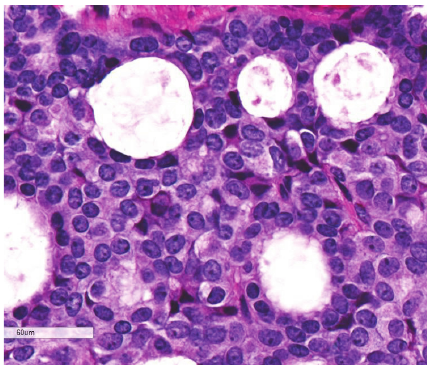
Figure 3: High power H&E slide. Both intracytoplasmic and extracellular mucin are present.